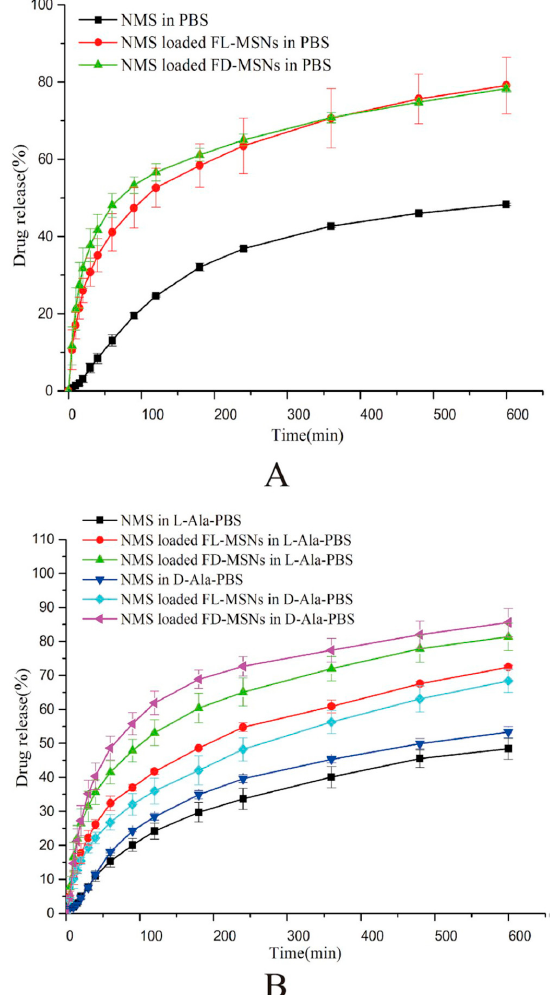
Figure 10. ( A ) In vitro release profiles of NMS, NMS loaded FL-MSNs, and NMS loaded FD-MSNs in pH 6.8 PBS. ( B ) In vitro release profiles of NMS, NMS loaded FL-MSNs, and NMS loaded